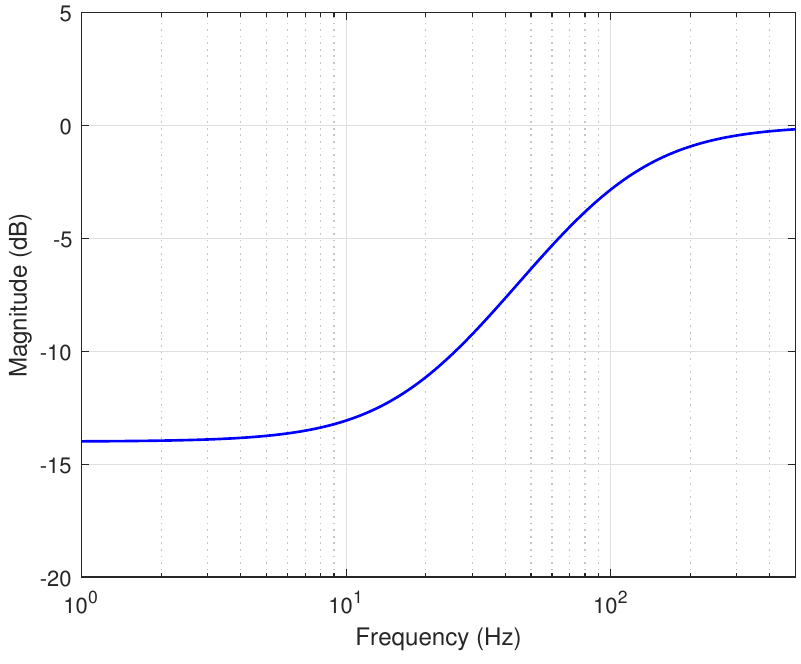
Figure 10. Weight function for OIS.